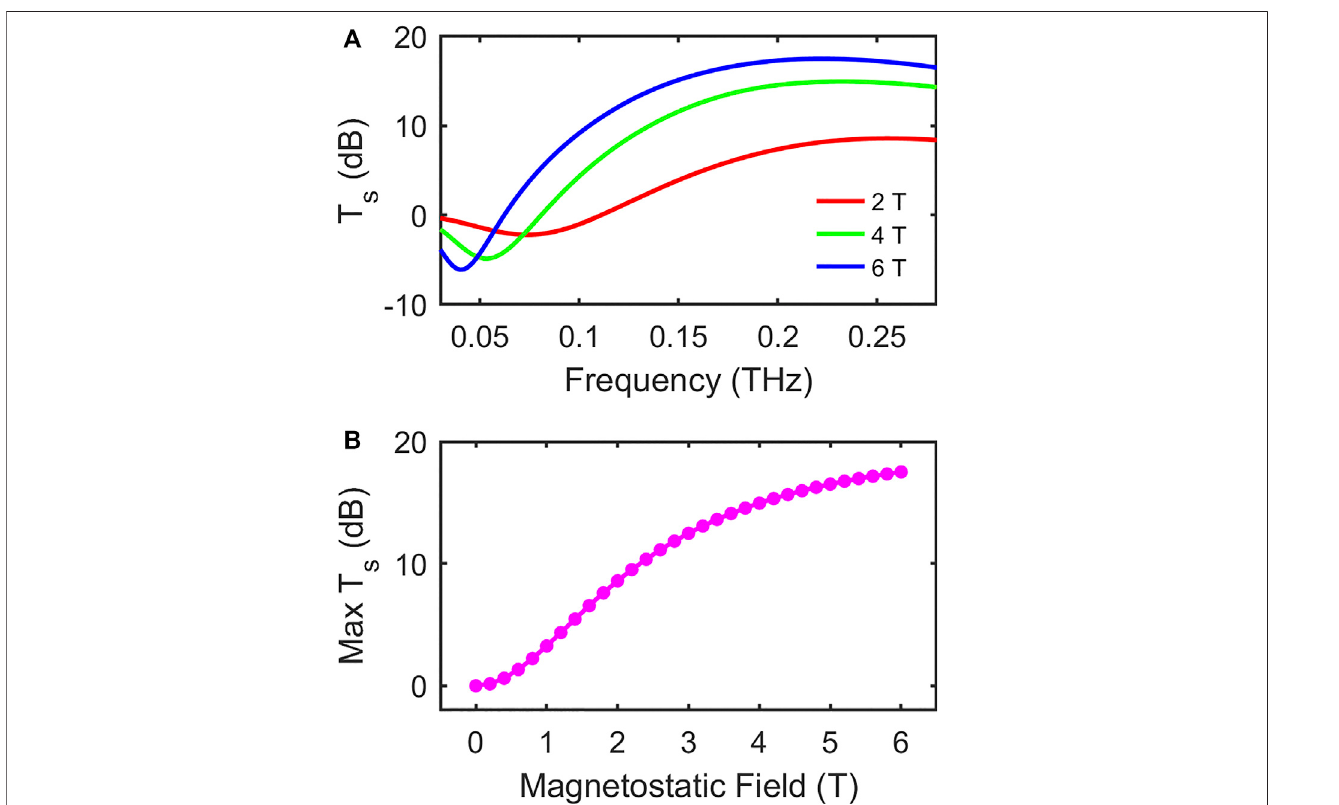
FIGURE 3 | (A) The difference between the transmittance curves of B 0 (cid:2) 2 T/4 T/6 T and the transmittance curve of B 0 (cid:2) 0 T. (B) The maximum of transmittance shift as a function of the values of the magnetic fl ux density applied.